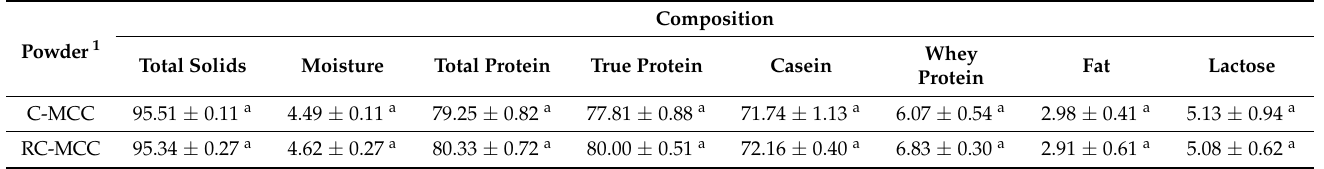
Table 1. Mean (n = 3) chemical composition of the micellar casein concentrate powders (% wt./wt.).